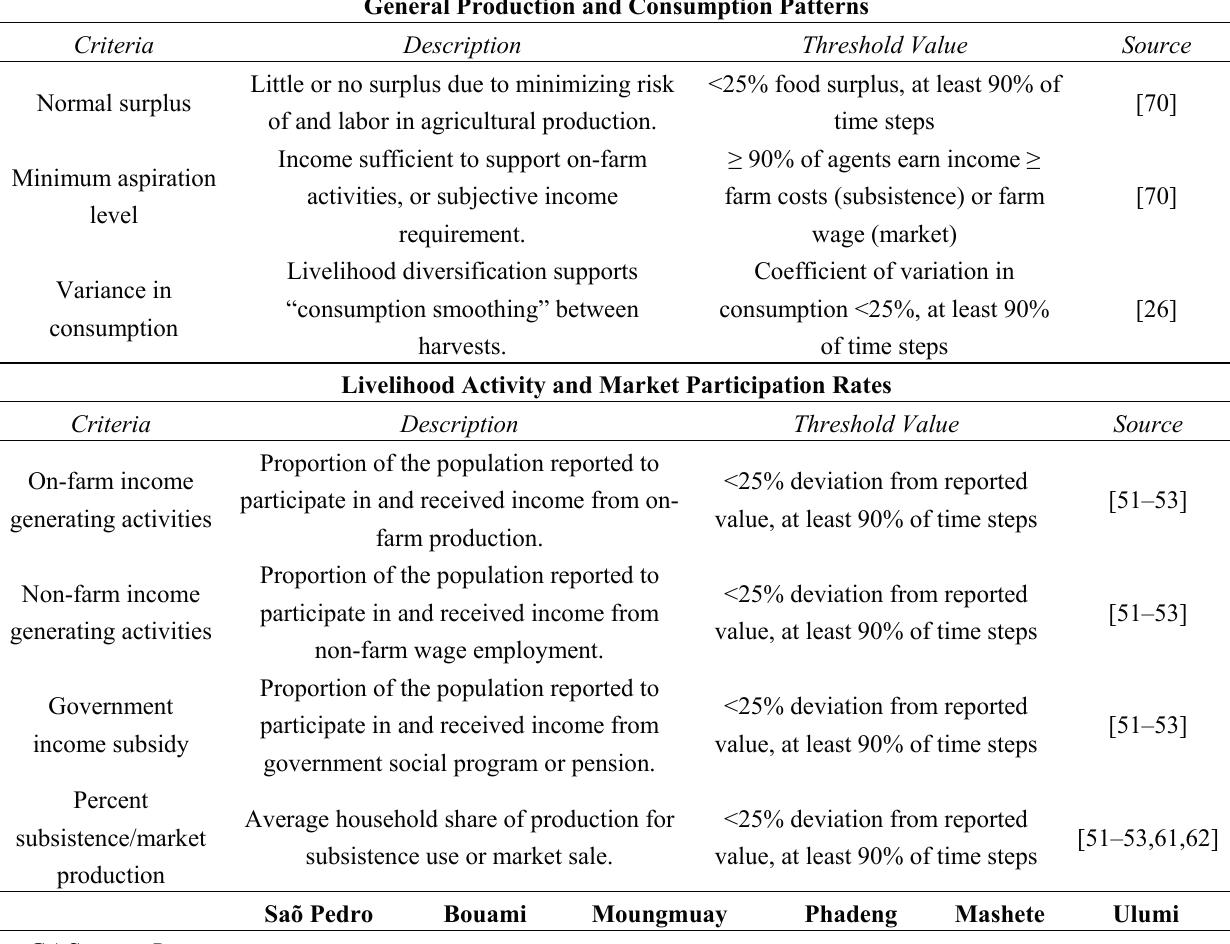
Table 4. Selected target patterns describing production and consumption behavior used in a pattern-oriented modeling (POM) approach to parameterize the general model for each test case. Threshold values were specified as performance criteria for a genetic algorithm (GA) using the local factors described in Table 3. The success rate of the GA, expressed as the percentage of total number of parameter sets that produce model outcomes that fulfilled all performance criteria, provides a measure of how well the generalized model performed for each